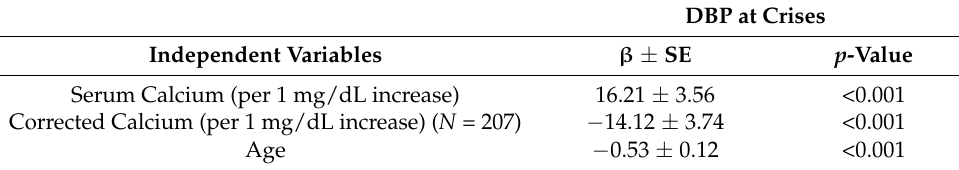
Table 5. Association of best independent variables with DBP at crises using linear model.